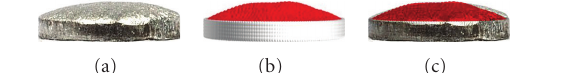
Figure 9: Comparison between experimentally obtained seal shape (a) and shapes predicted by the simulation (b), and an overlay of simu- lation and experiment (c).